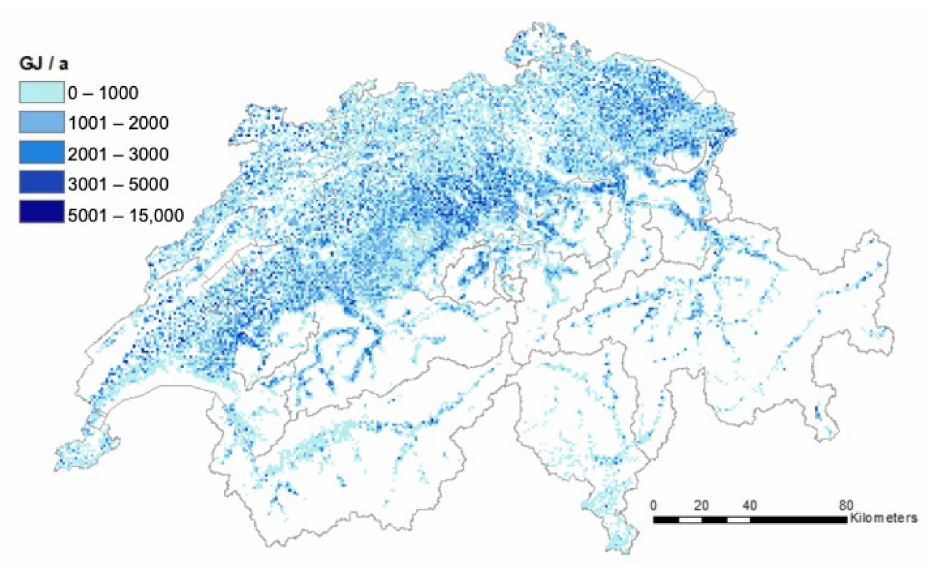
Figure 4. Technical potential of manure and agricultural residues in GJ per year of biogas yield.